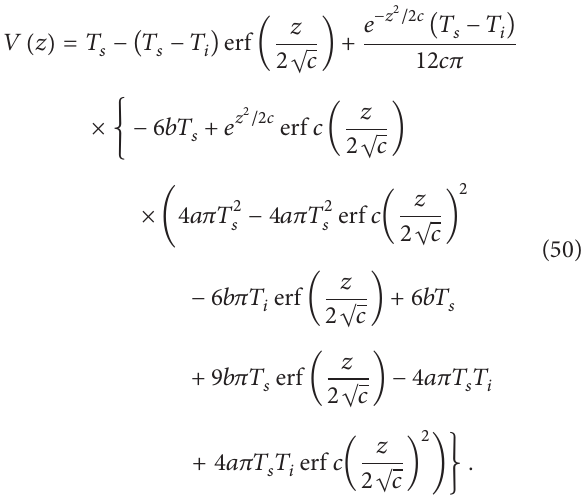
Figure 8: Initial approximation 𝑉 of BVP (47), (48).